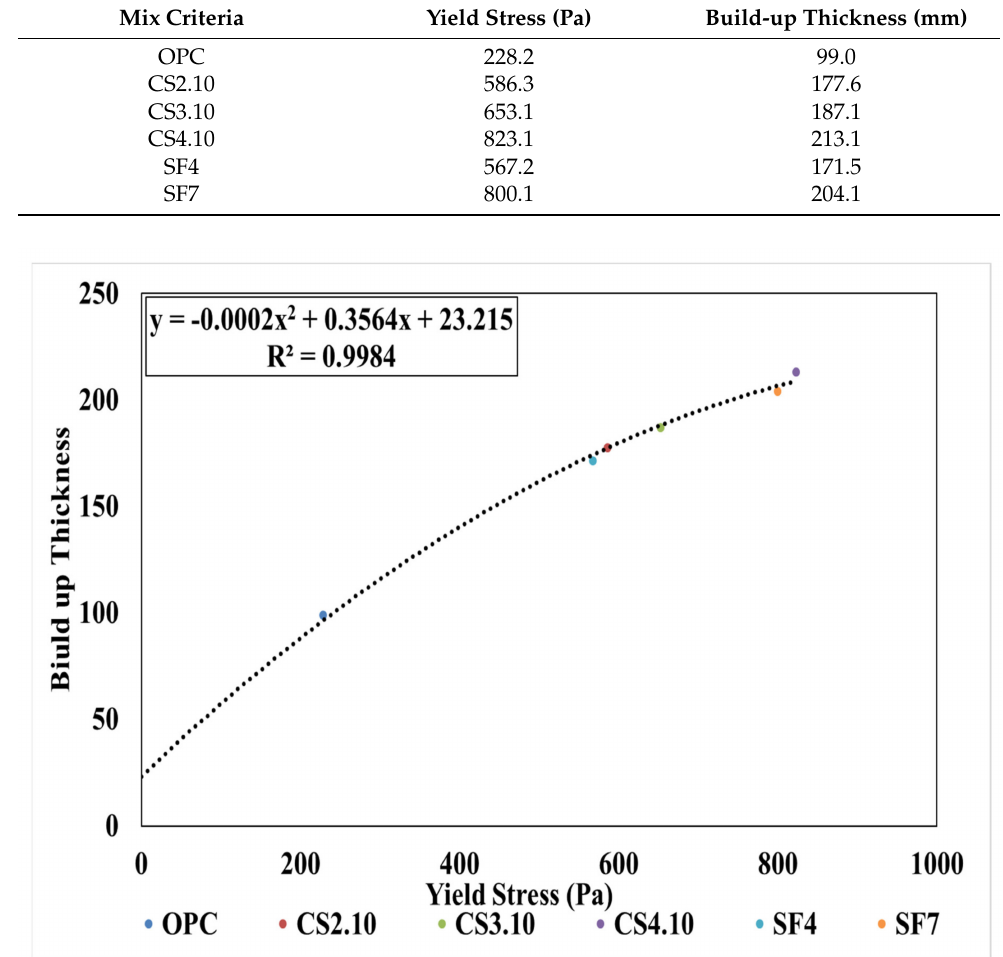
Figure 23. Build-up thickness measuring using Bingham yield